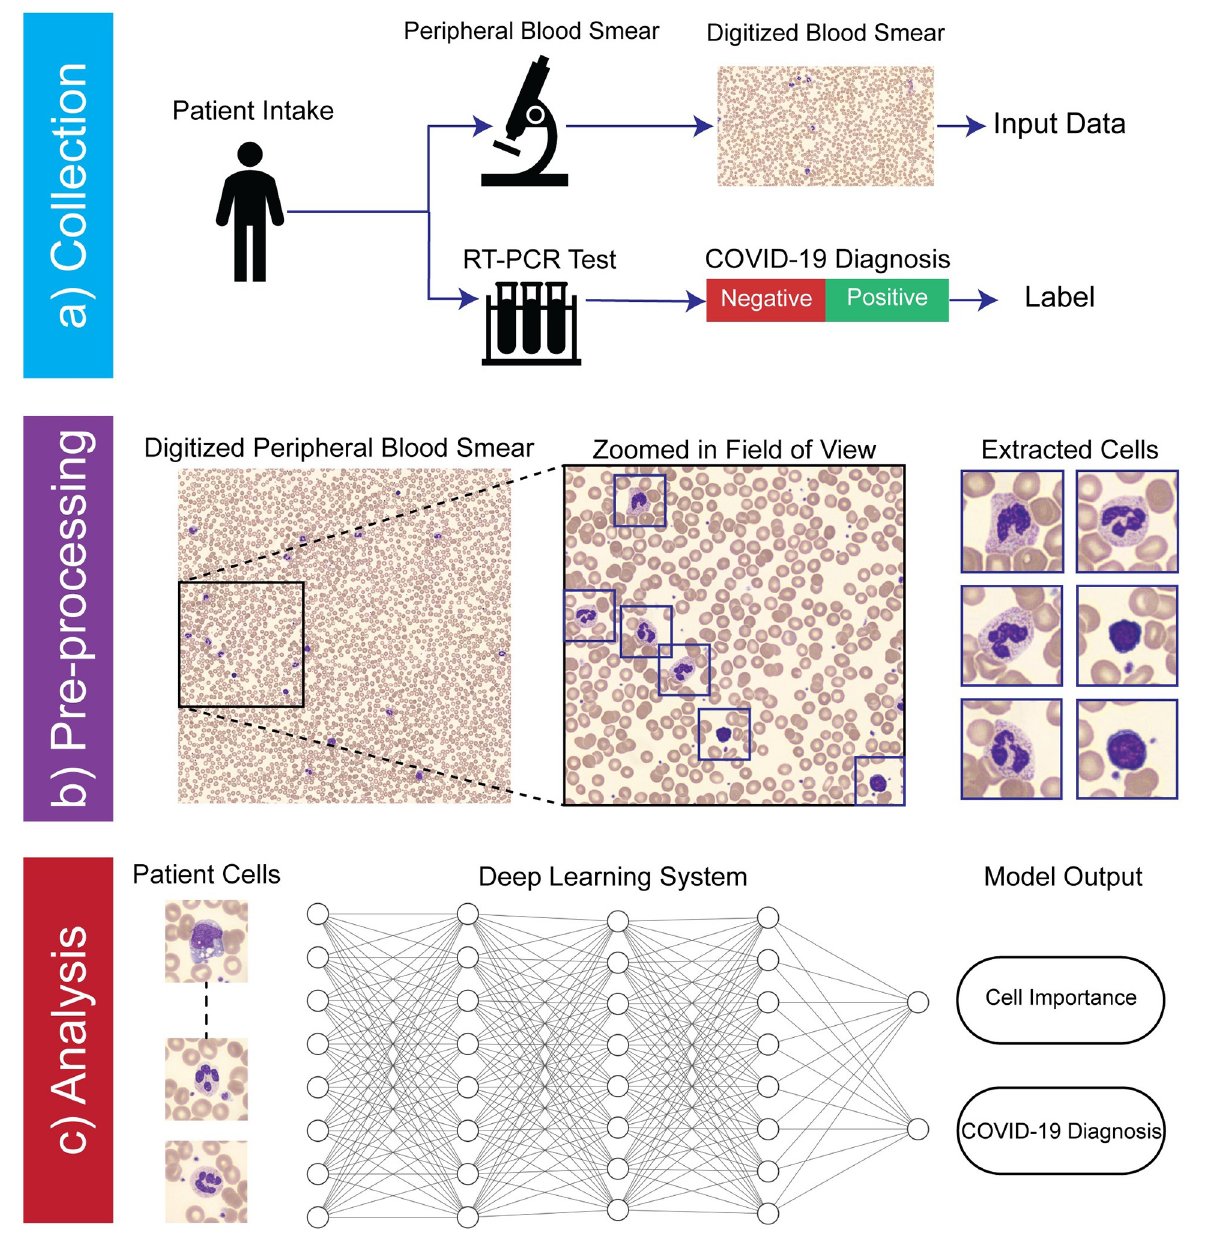
Fig 1. Workflow of automated COVID-19 infection analysis from peripheral blood smear (PBS) image data. a) Data collection procedure at Duke University Medical Center. Subjects were randomly selected from patient population subset who had both a COVID-19 RT-PCR test (ground truth labels) and images from a digital PBS scan (input data). All data was collected anonymously, retaining only the results of the RT-PCR test and digitized PBS images. b) Summary of pre-processing pipeline, where individual images of white blood cells are extracted from the full slide using a high- resolution oil-immersion microscope. c) Data analysis strategy. All cells from a patient are collectively analyzed by a deep neural network to produce both a COVID-19 diagnosis and per-cell importance score.